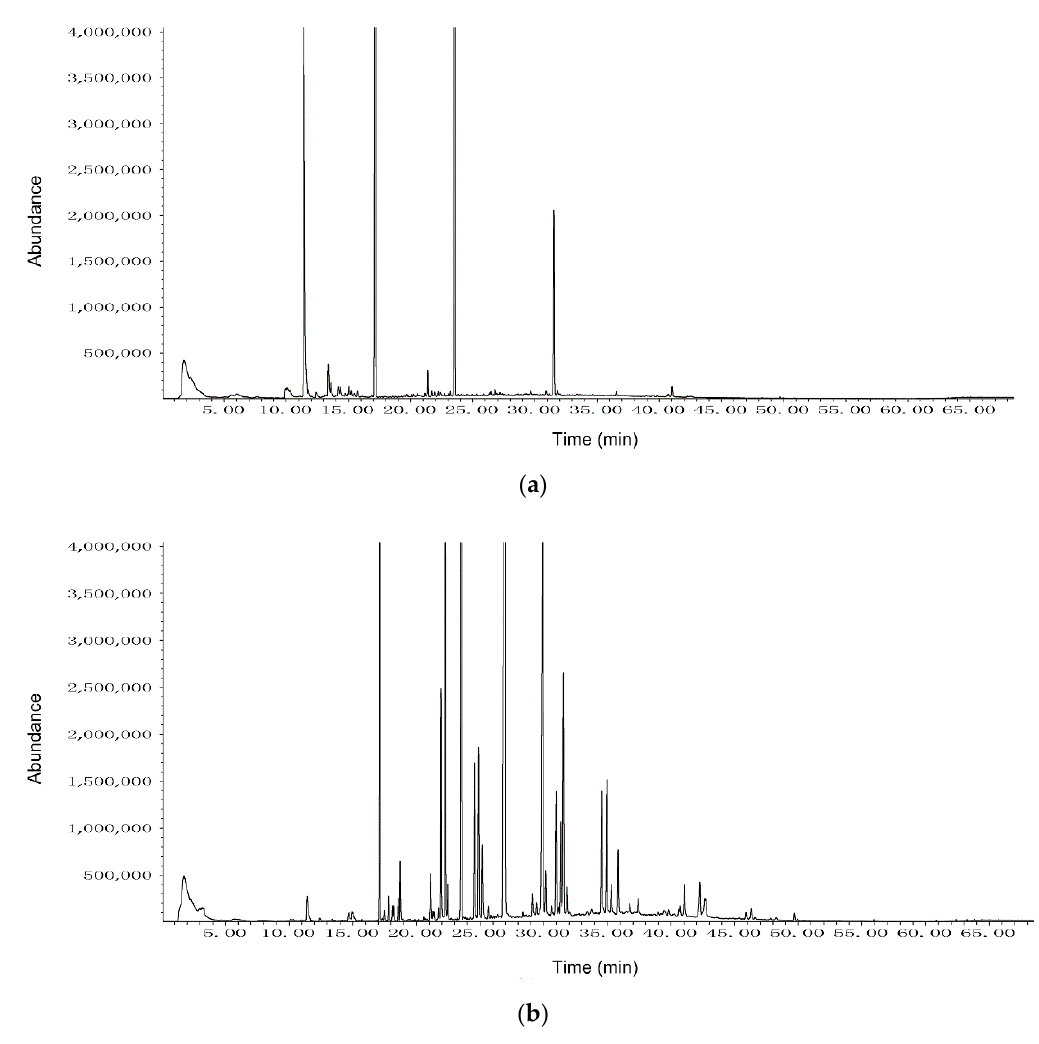
Figure 3. ( a ) Total ion chromatogram of VOCs from uninoculated nutrient agar (NA) medium; ( b ) total ion chromatogram of VOCs from strain CT32.